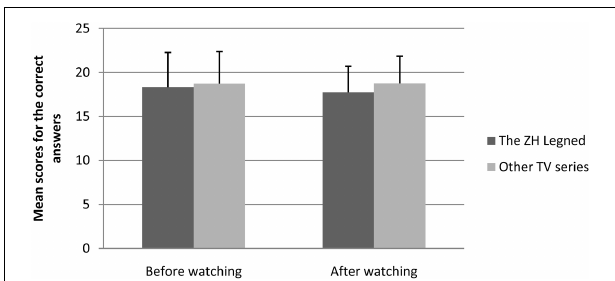
FIGURE 1 | Mean scores and standard deviations for the correct answers on the general knowledge (self-report) by the testing time and type of TV series watched.